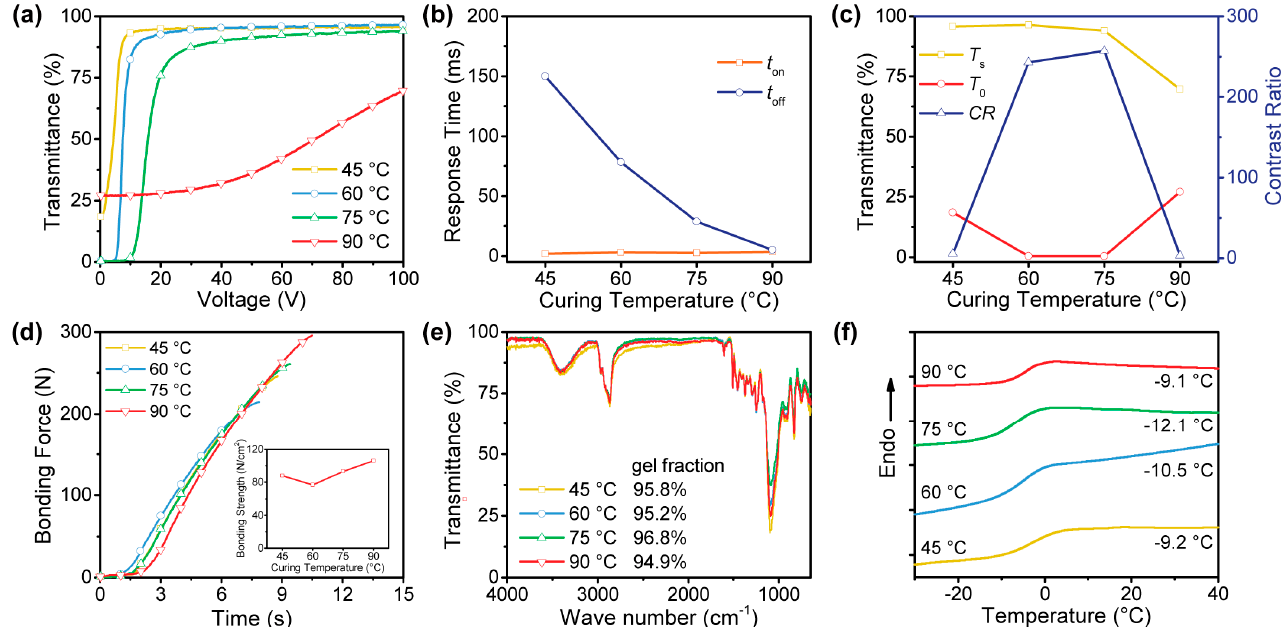
Figure 4. ( a ) The voltage dependence of the transmittance, ( b ) the response time, ( c ) the saturation transmittance, off-state transmittance, contrast ratios, and ( d ) adhesion strength of samples B1–B4; ( e ) FTIR spectra and gel fractions and ( f ) DSC thermographs of the polymer matrix of samples B1–B4.